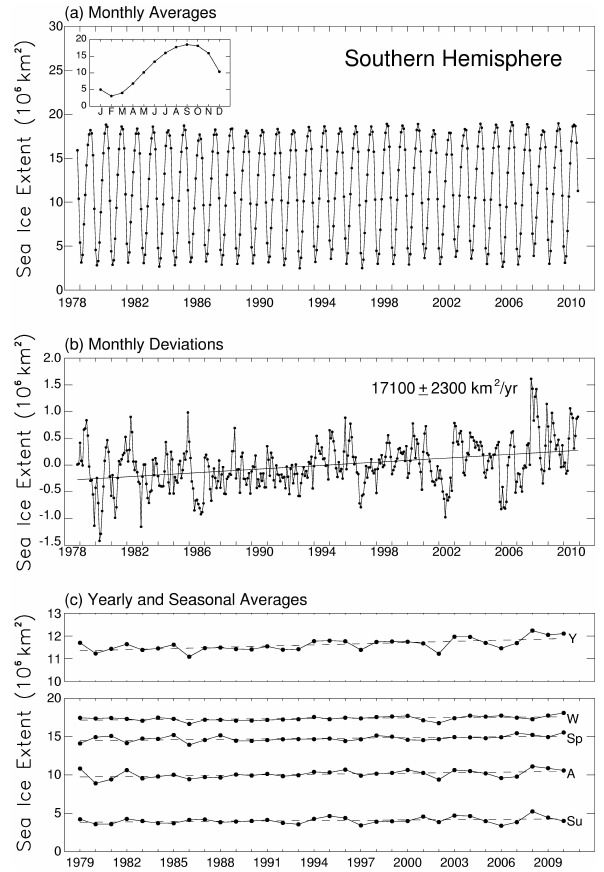
Fig. 3. (a) Monthly average Southern Ocean sea ice extents for November 1978 through December 2010, with an inset showing the satellite data. (b) Monthly deviations for the sea ice extents of part a, with the line of least squares fit through the data points and its slope and standard deviation. (c) Yearly (Y) and seasonally